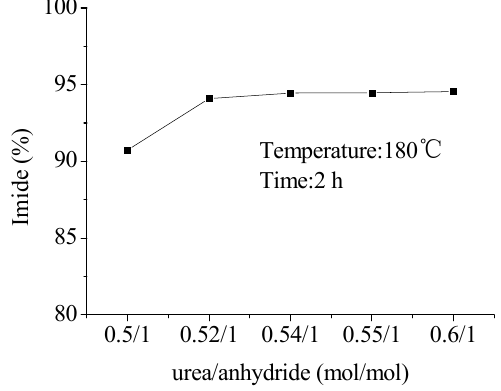
Figure 1. Effects of the amount of urea on the content of